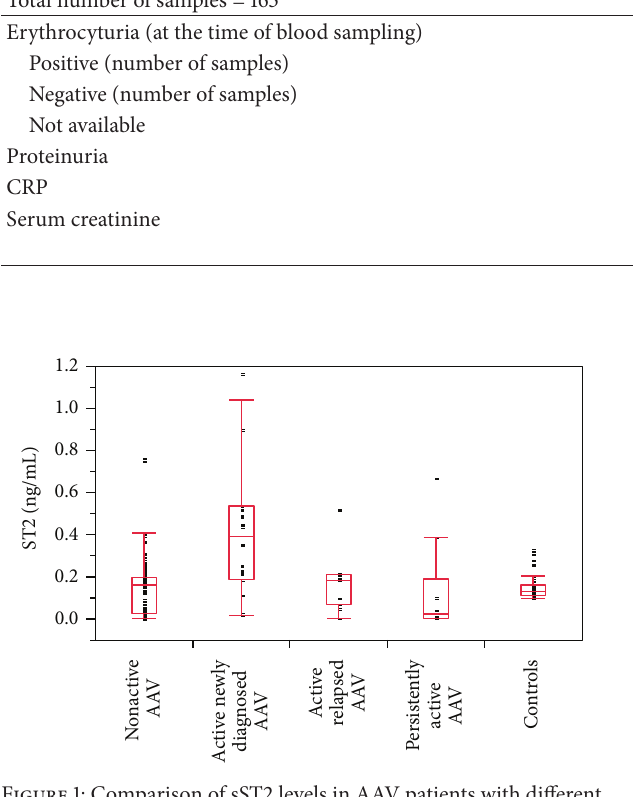
Figure 1: Comparison of sST2 levels in AAV patients with different disease activity stages and controls. ST2 levels were higher in active newly diagnosed AAV versus nonactive AAV ( 𝑃 < 0.001 ), persistently active AAV: 𝑃 < 0.001 , and controls ( 𝑃 < 0.01 ). No other significant differences were found. Box plot graph: boxes represent 25–75 percentile (50% of results in the box = interquartile range (IQR), bottom is the first quartile, top is the third quartile, and median is represented by the line). Whiskers are lines extending vertically from the boxes, which indicate variability outside the upper and lower quartiles. Results which are not included between the whiskers are plotted as an outlier with a